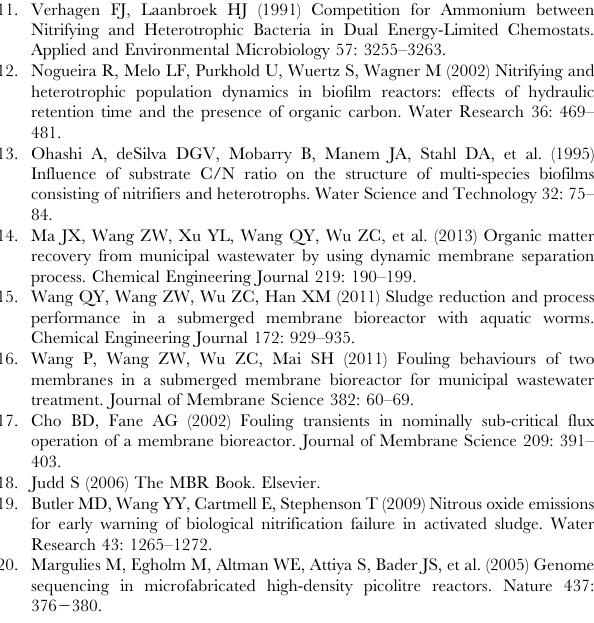
Figure S1 Schematic of R 0 fed with low COD/N-ratio municipal wastewater. (TIF) Figure S2 Nonlinear curve fit of Y and K d , and analysis of variance (ANOVA). (TIF) Figure S3 Rarefaction curves of OTUs defined by 3%, 5% and 10% distances in R 0 –R 5 sludge samples. (TIF) Table S1 Substrate composition for SOURs. Text S1 More information on MBR